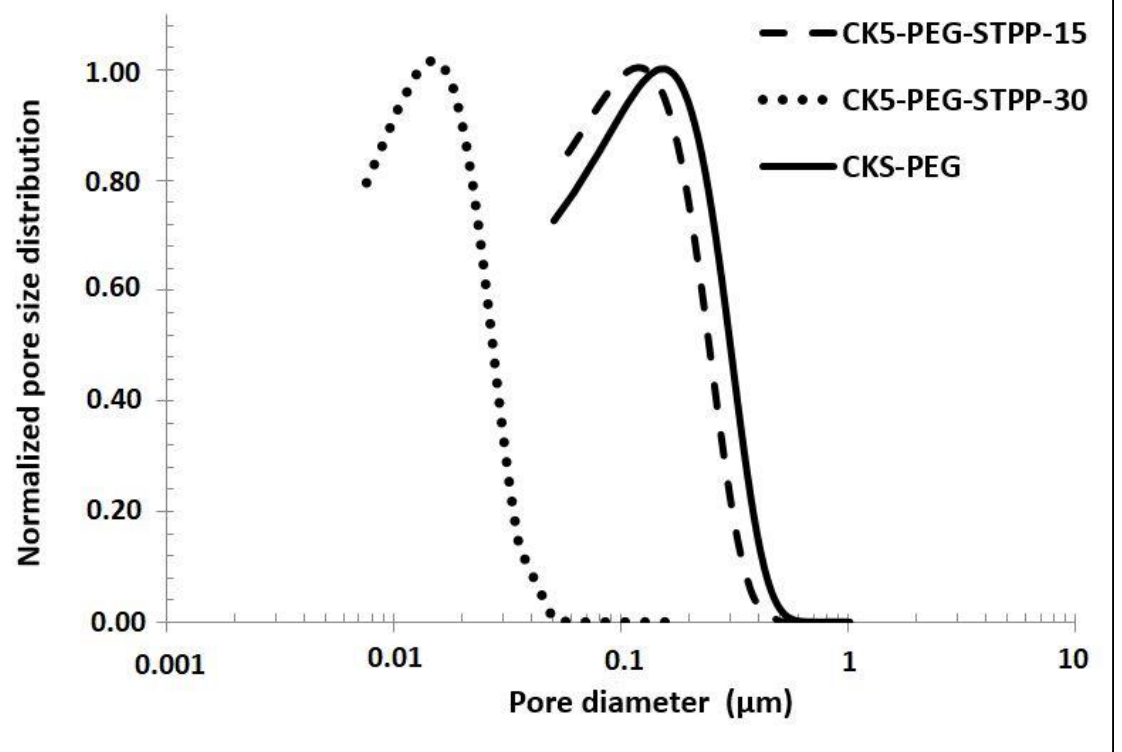
Figure 4. Pore size distribution determined by image analysis of SEM top surface of composite membranes after 0, 15 and 30 min reaction time with STPP.